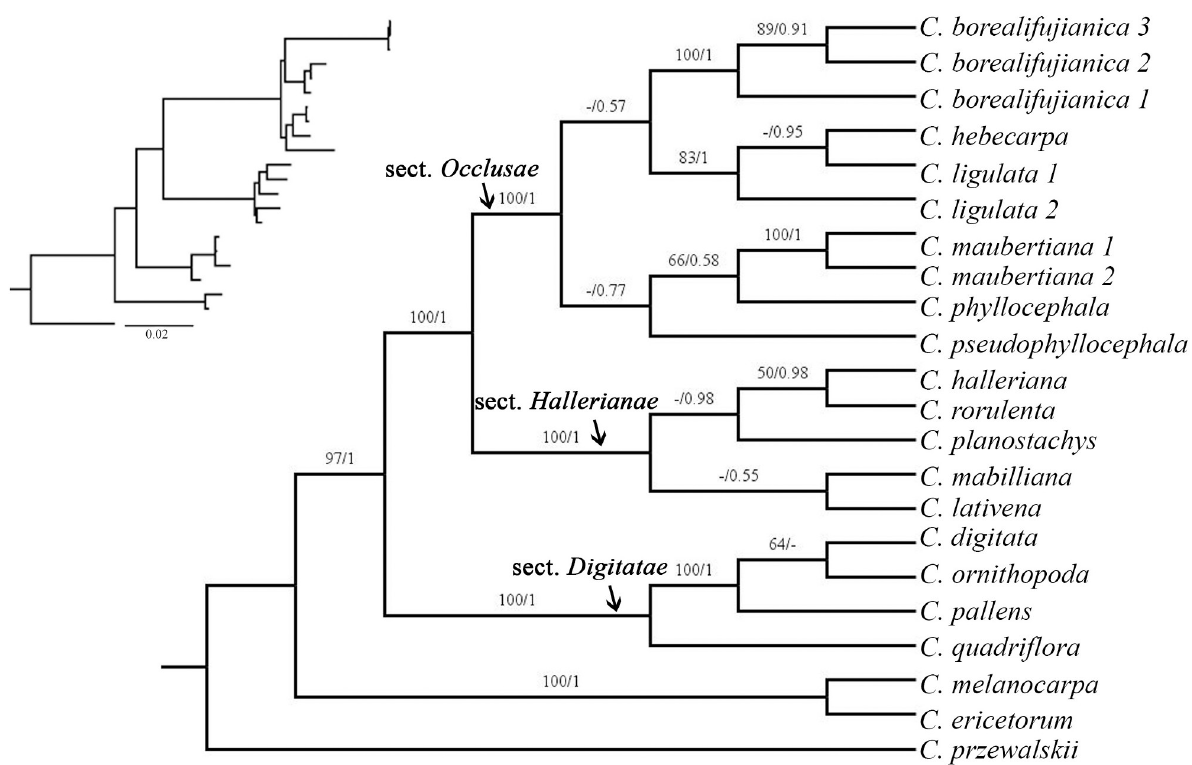
Fig 4. Maximum likelihood (ML) tree from the combined data (ETS, ITS, mat K and trn L-F), showing the relationship of Carex borealifujianica . Values above branches represent bootstrap values (BS) for maximum likelihood and Bayesian posterior probabilities (PP) respectively, and (-) indicates the BS < 50% or PP <